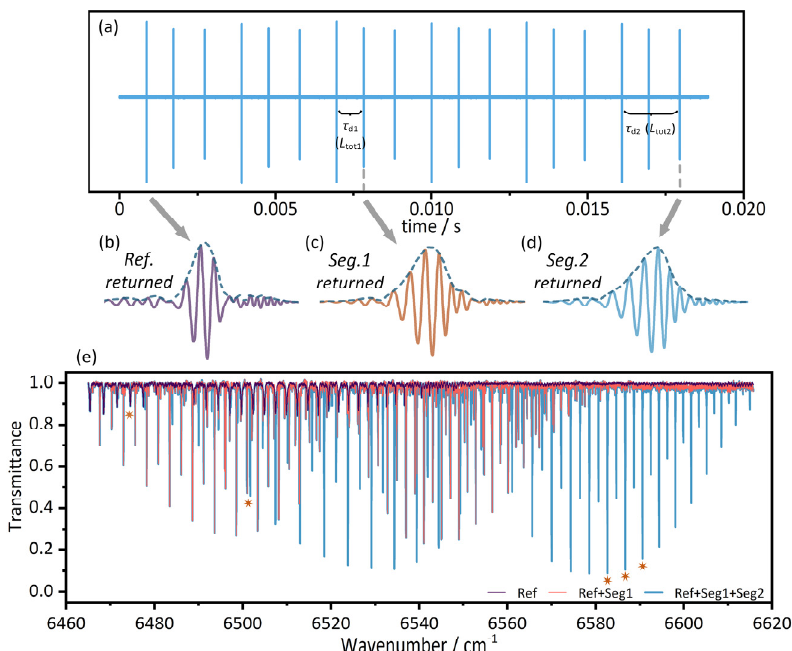
Figure 4. IGMs at different scales and the corresponding spectra. ( a ) Part of the measured continuous IGMs. ( b ), ( c ) and ( d ) Expanded view of the IGMs that returned from different segments (lasting 1.6 µ s) and their envelopes extracted by Hilbert transform and interpolate. ( e ) Part of the transmission curves derived from corresponding IGMs.